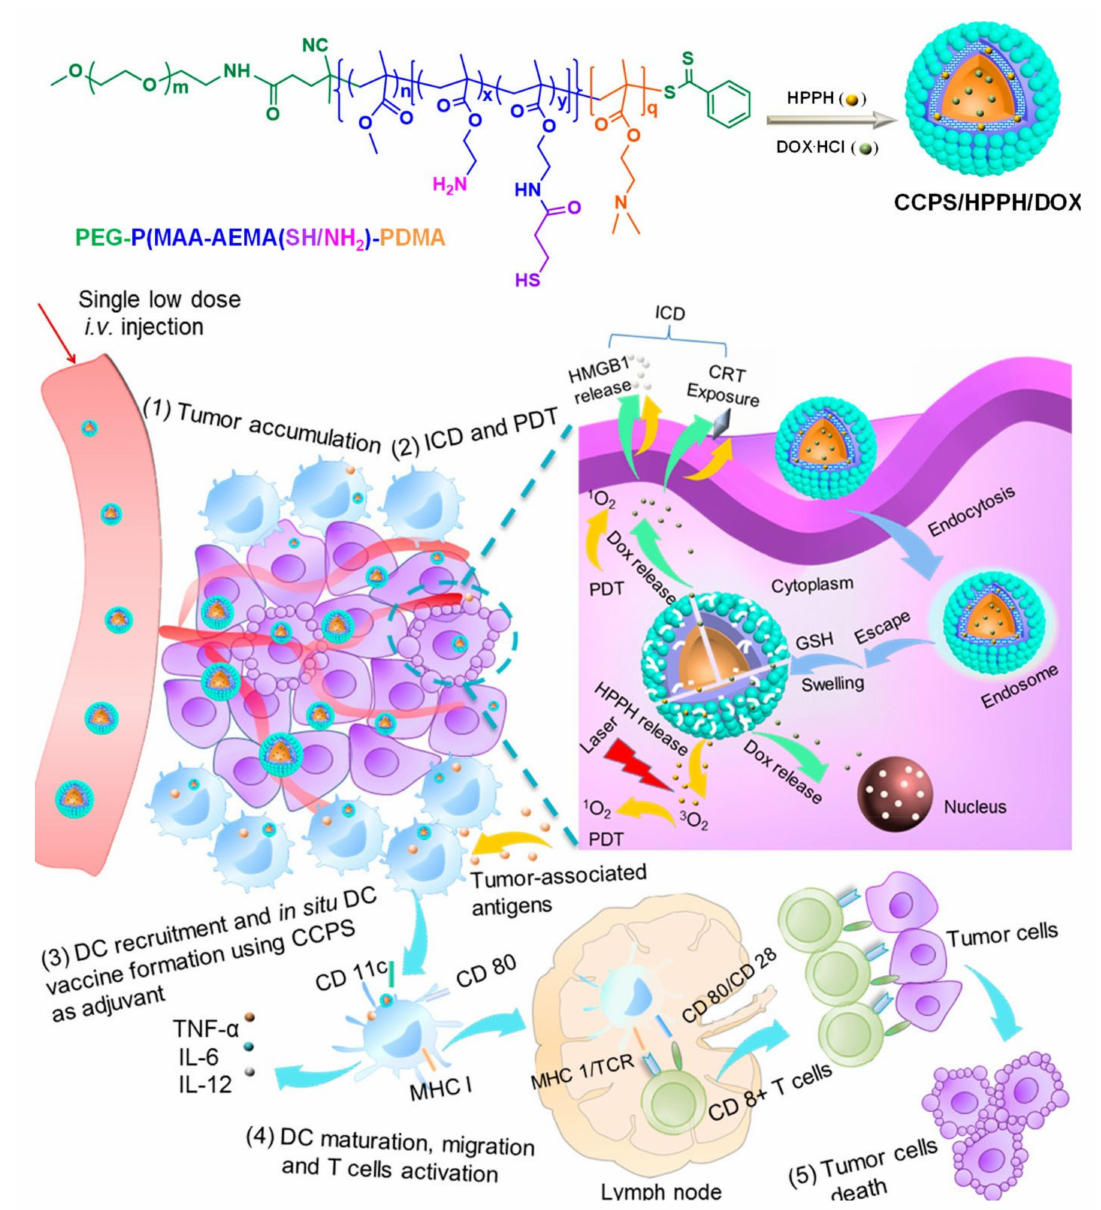
Figure 4. Delivery of adjuvants. Schematic illustration of a DC vaccine made of chimeric cross-linked polymersomes as an adjuvant and tumour-associated antigens induced by PDT and ICD for MC38 colorectal cancer immunotherapy. [31] Copyright ACS